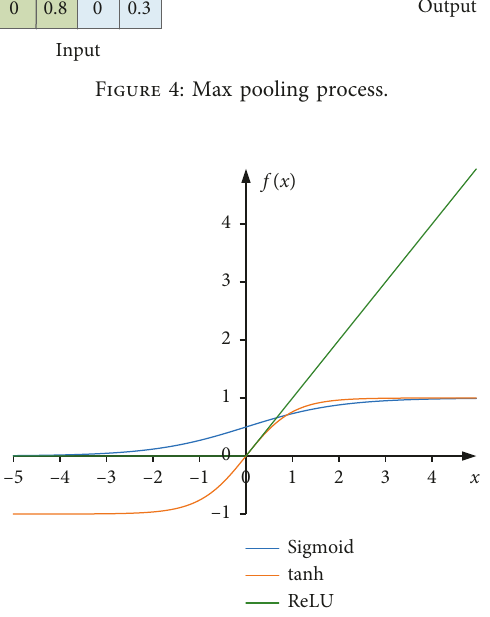
Figure 5: Nonlinear activation functions.